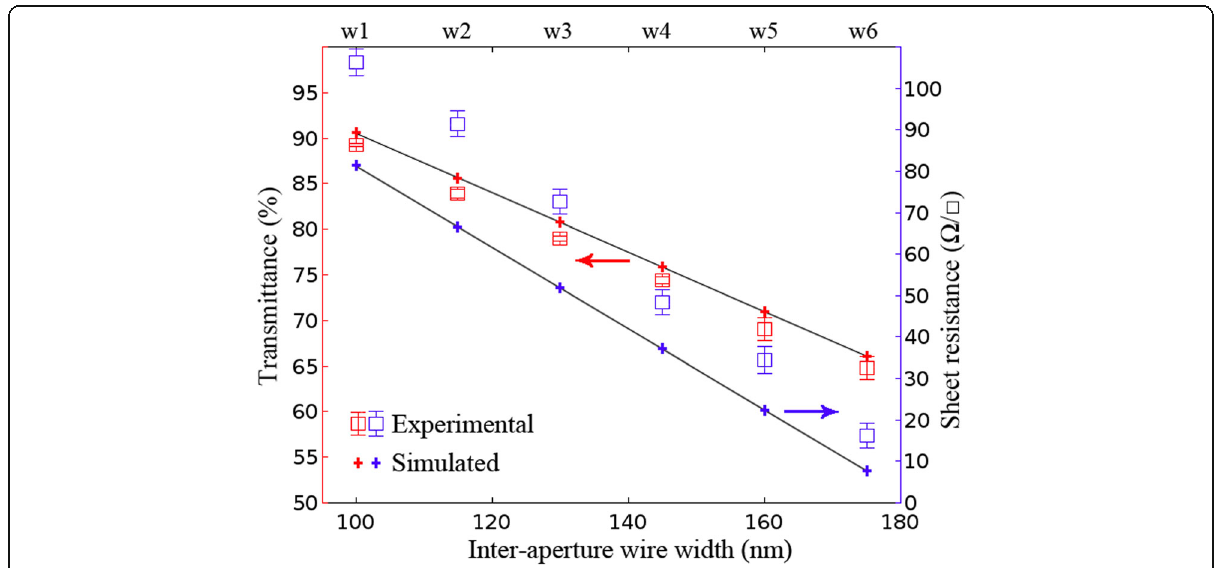
Fig. 3 Transmittance and sheet resistance vs. inter-aperture wire width of AuNM (at λ = 550 nm and thickness = 20